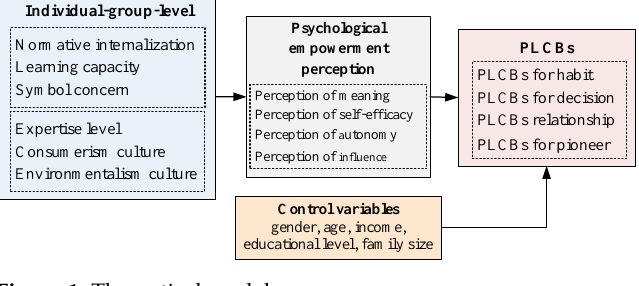
Figure 1. Theoretical model.